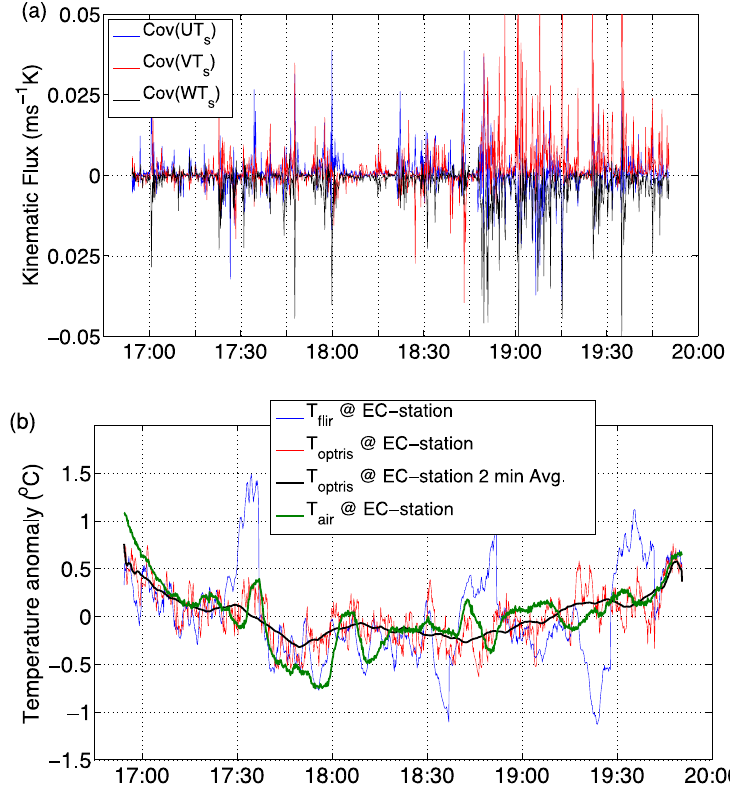
Figure 4. ( a ) Turbulent kinematic heat flux in the three Cartesian directions (U for east-west, V for north-south, and W in the vertical). Statistically, the heat flux was calculated based on the covariance of the velocity and sonic temperature; ( b ) Time series of brightness and air temperature at the eddy covariance area-averaged site.